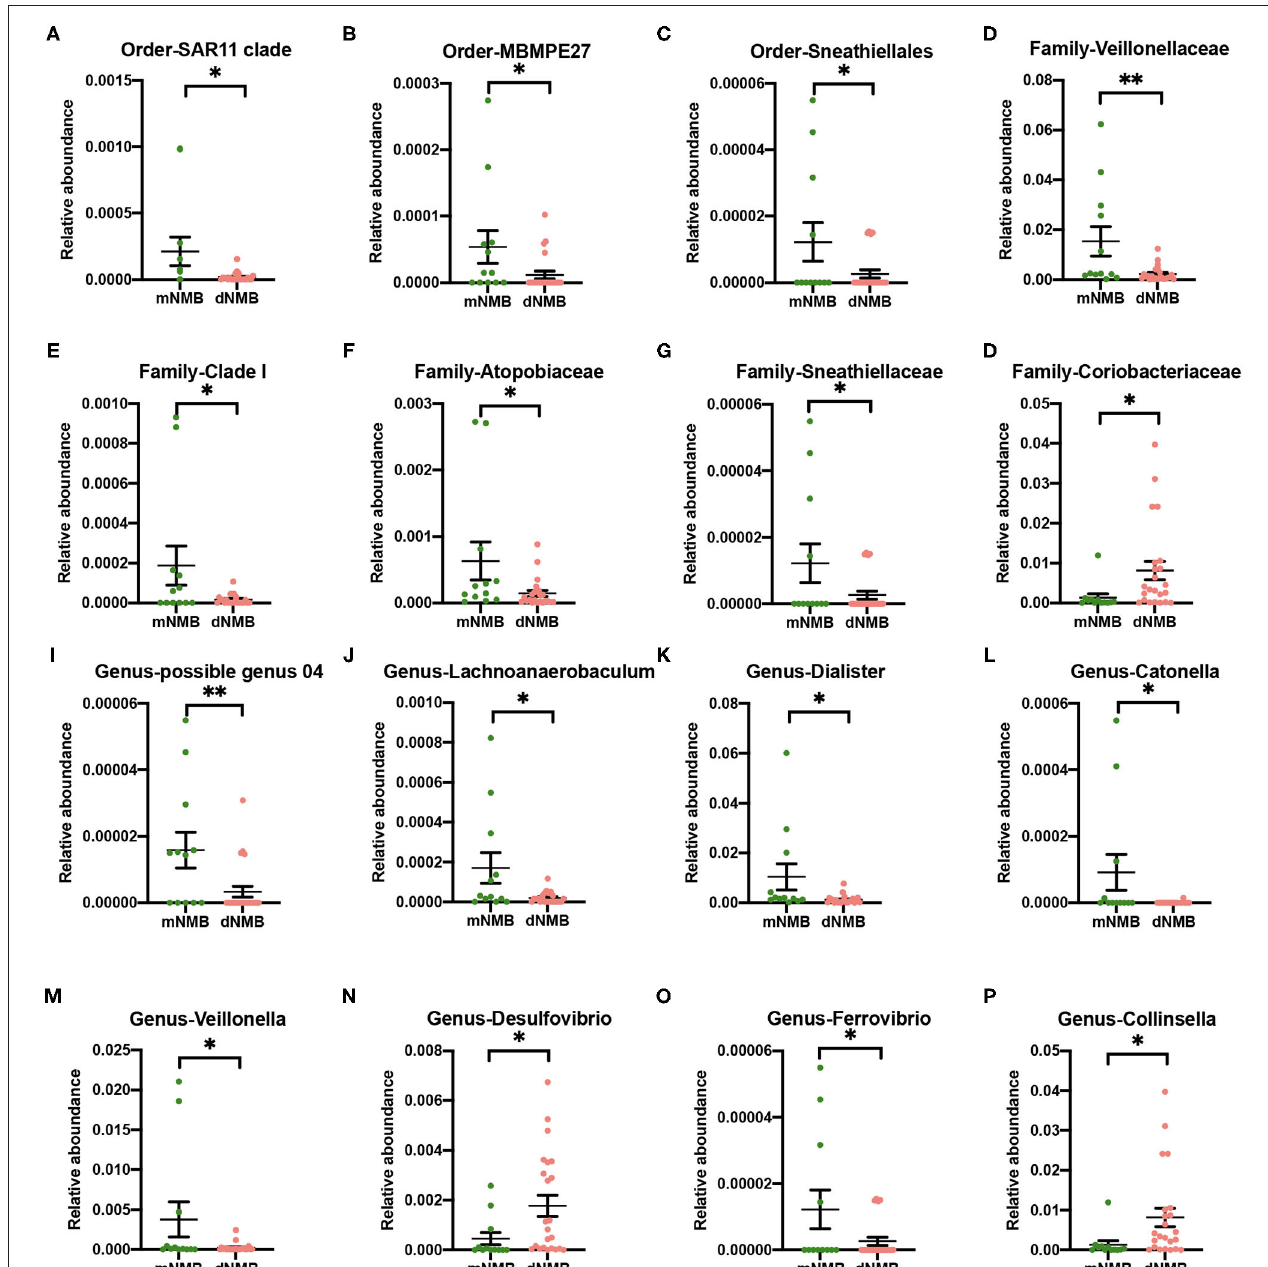
FIGURE 3 | Alterations in the levels of gut microbiota between the deep NMB and moderate NMB group. (A) Order SAR11 clade ; (B) Order MBMPE27 ; (C) Order Sneathiellales ; (D) Family Veillonellaceae ; (E) Family Clade I ; (F) Family Atopobiaceae ; (G) Family Sneathiellaceae ; (H) Family Coriobacteriaceae ; (I) Genus possible genus 04 ; (J) Genus Lachnoanaerobaculum ; (K) Genus Dialister ; (L) Genus Catonella ; (M) Genus Veillonella ; (N) Genus Desulfovibrio ; (O) Genus Ferrovibrio ; (P) Genus Collinsella . * p < 0.05, ** p < 0.01. dNMB, deep neuromuscular blockade; mNMB, moderate neuromuscular